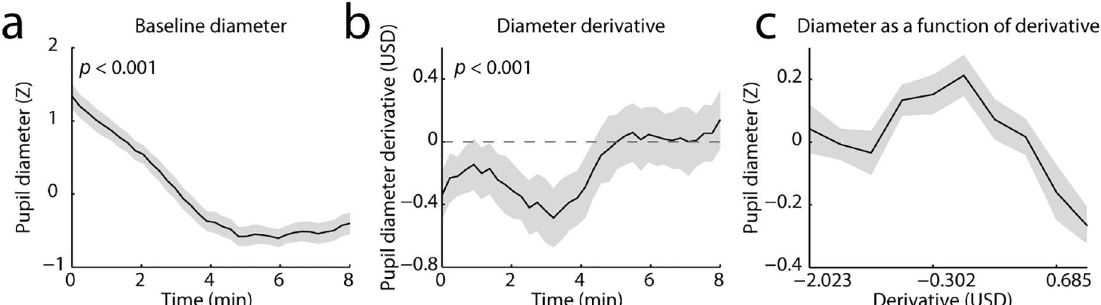
Fig 3. Baseline diameter and derivative. a) Time-on-task effect for baseline diameter, and b) for diameter derivative. p- values are listed in the top left corner of each panel. The derivativeis shown as variance-normalizedbut without the mean removed. Values below the horizontaldotted line indicate that on average the pupil is constricting, whereas values above the line indicate that the pupil is dilating. c) The relationship between pupil diameter and its derivative. Baselinepupil diameter plotted as a function of the derivative. Diameter is smallest when the pupil is dilating the fastest. USD: Units standard